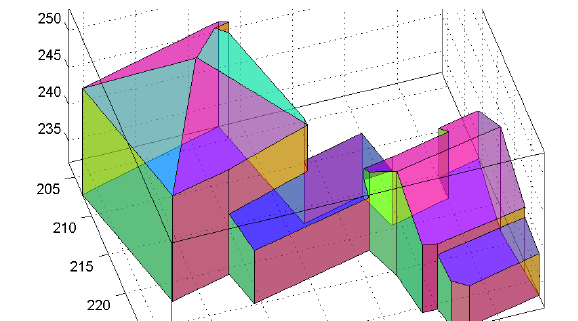
Figure 8: Constrained boundary representation as the result of the reasoning and adjustment process. 38 functionally independent constraints have been recognized and enforced, cf. Table 2. The reasoning process led to a more adequate representation of the pyramidal broach